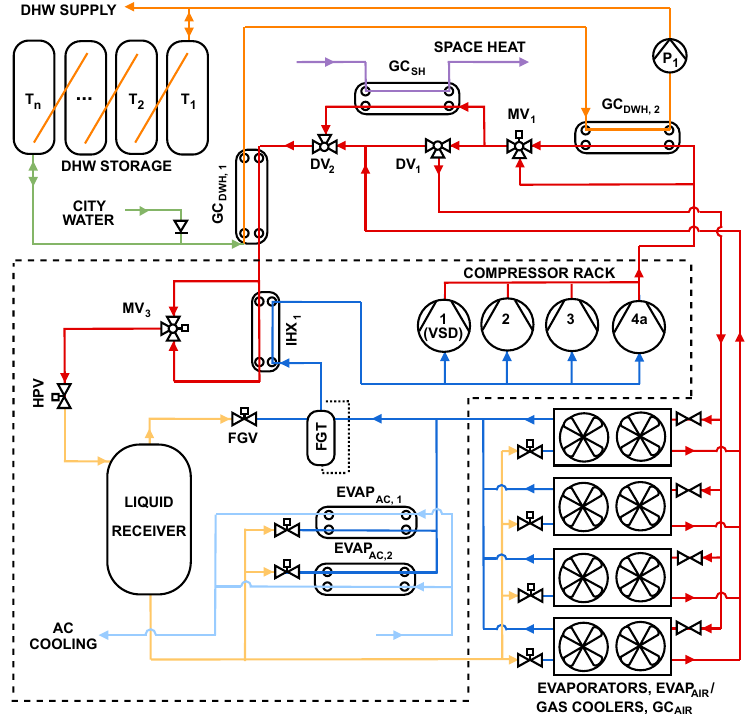
Figure 1. Simplified representation of the standard integrated CO 2 concept, equipped with single- stage compression (SC). High-pressure lines are indicated in red, intermediate pressure lines in yellow, and low-pressure lines in dark